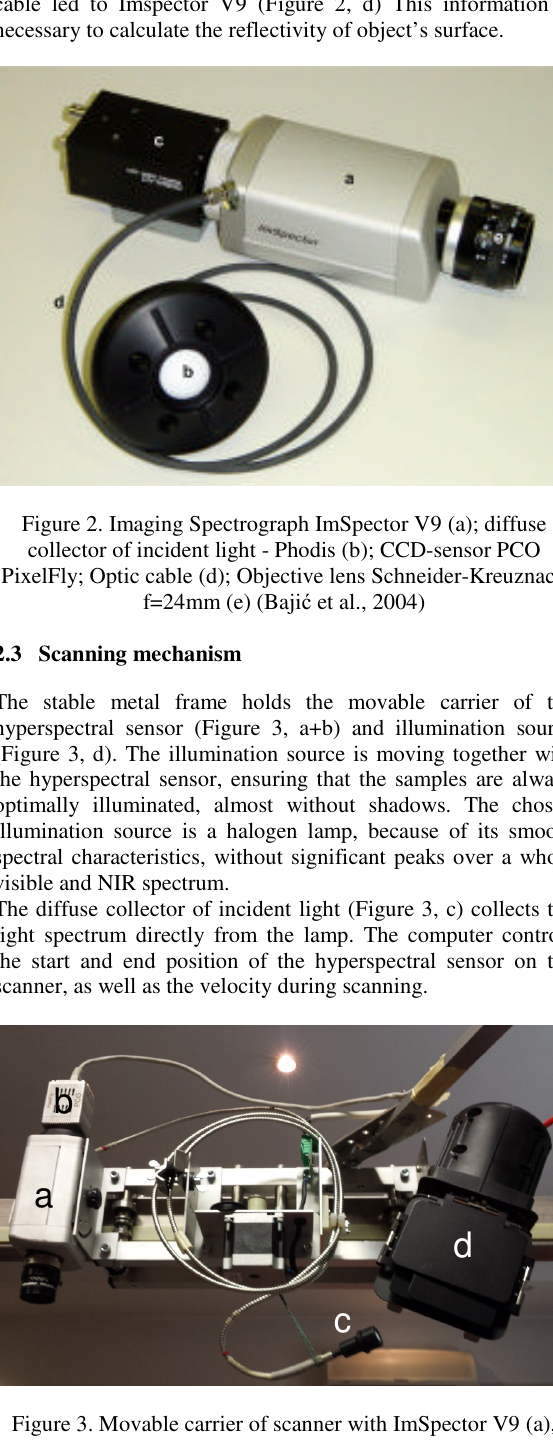
Figure 3. Movable carrier of scanner with ImSpector V9 (a), CCD sensor PixelFly (b), diffuse collector of incident light (c) and source of light (d)